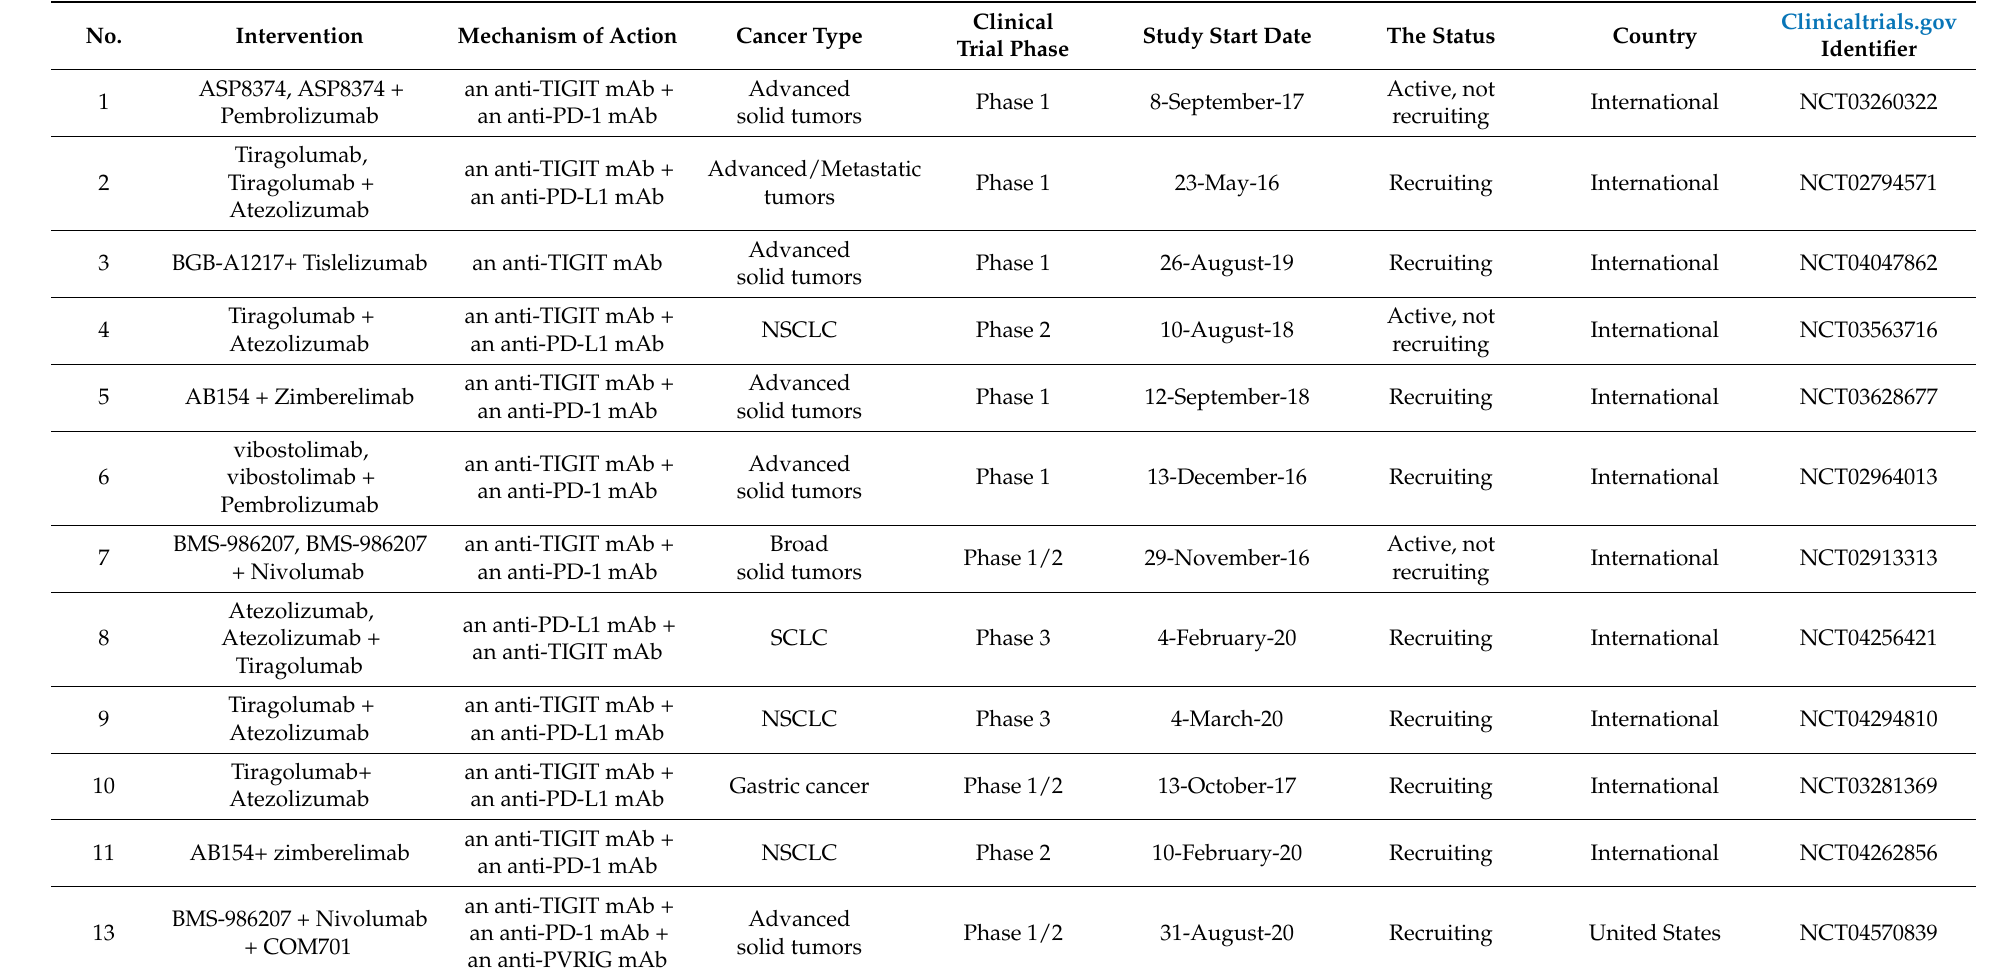
Table 4. The current clinical trials for targeting TIGIT immune